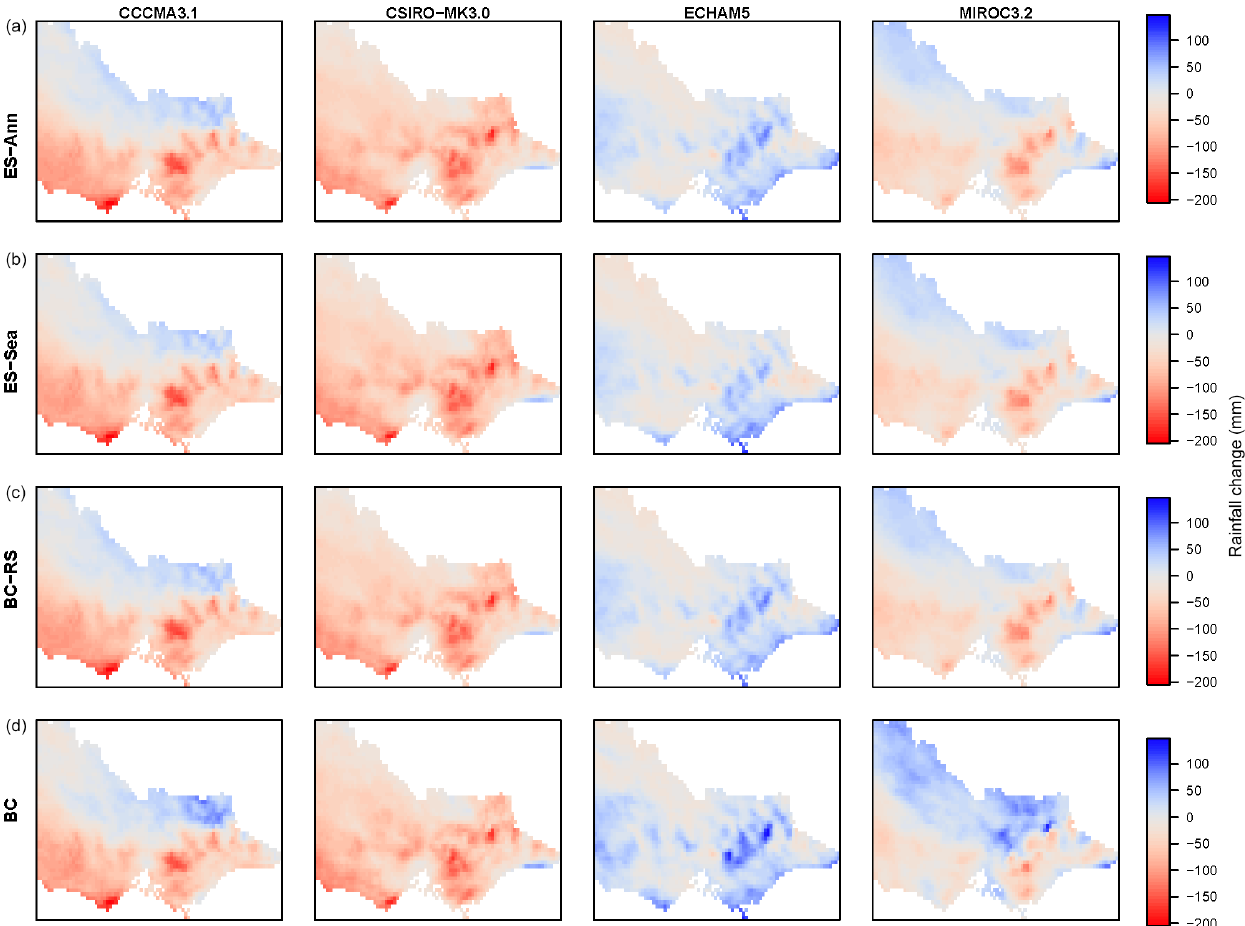
Figure 4. Mean annual rainfall change (mm) for (a) empirical annual scaling, (b) empirical season scaling, (c) BC rescaled (according to ES seasonal then annual changes) and (d) BC. Columns (left to right) show CCCMA3.1, CSIRO-MK3.0, ECHAM5 and